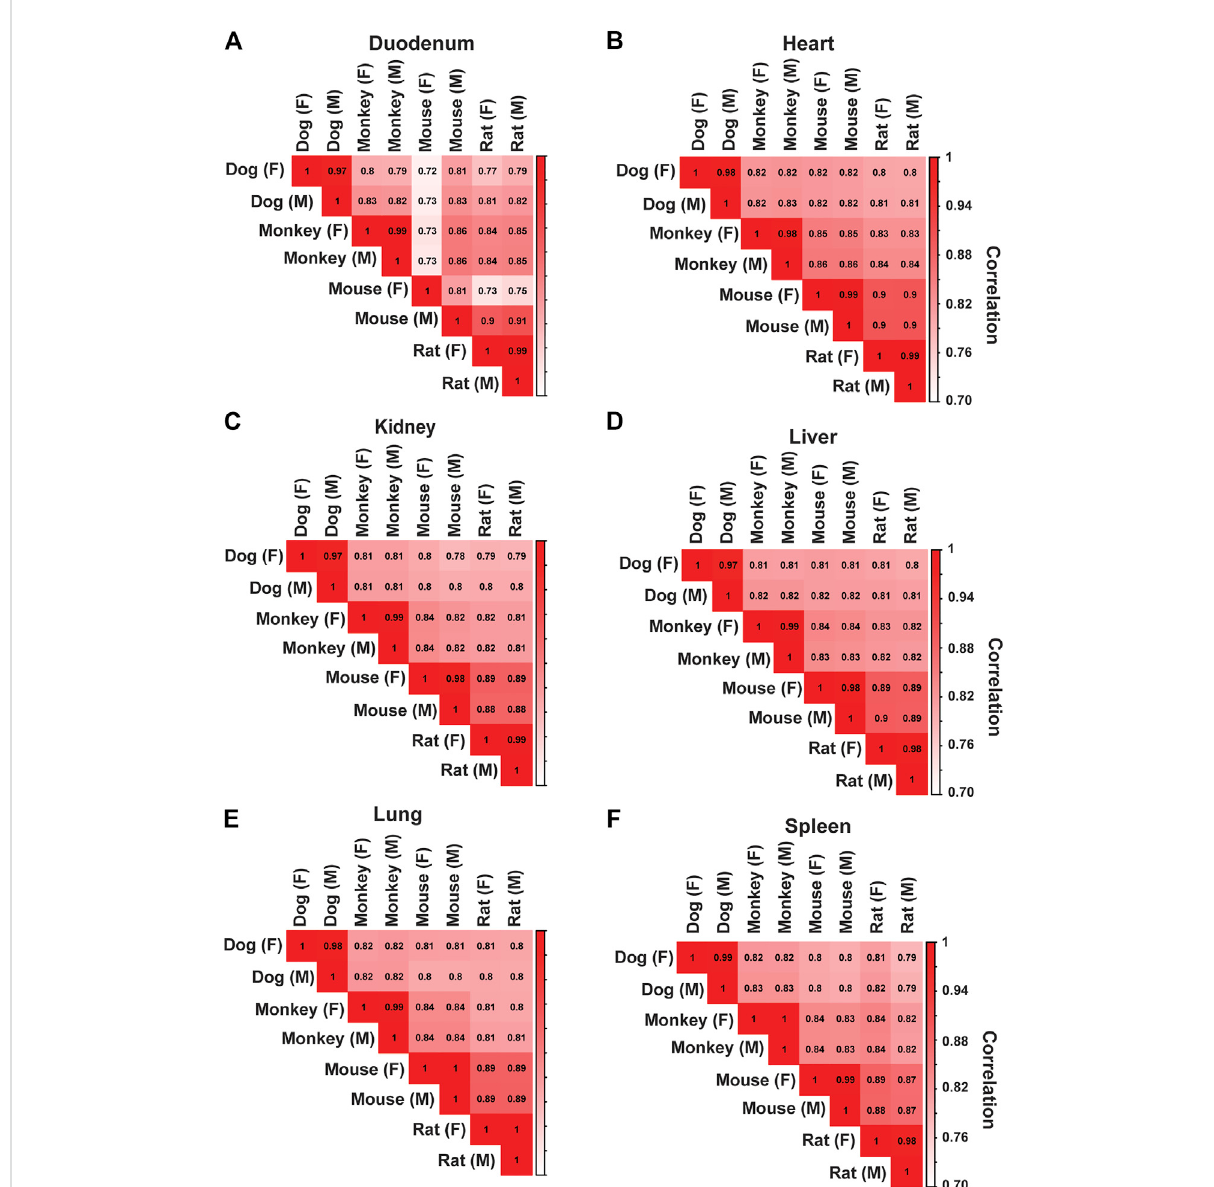
FIGURE 2 Correlation Analysis Across Species for Major Toxicity Organs. Correlation analysis was performed to assess species and sex differences across tissues. In both males (M) and females (F), spearman correlation coef fi cient values were generated across all species in (A) Duodenum, (B) Heart, (C) Kidney, (D) Liver, (E) Lung, and (F)